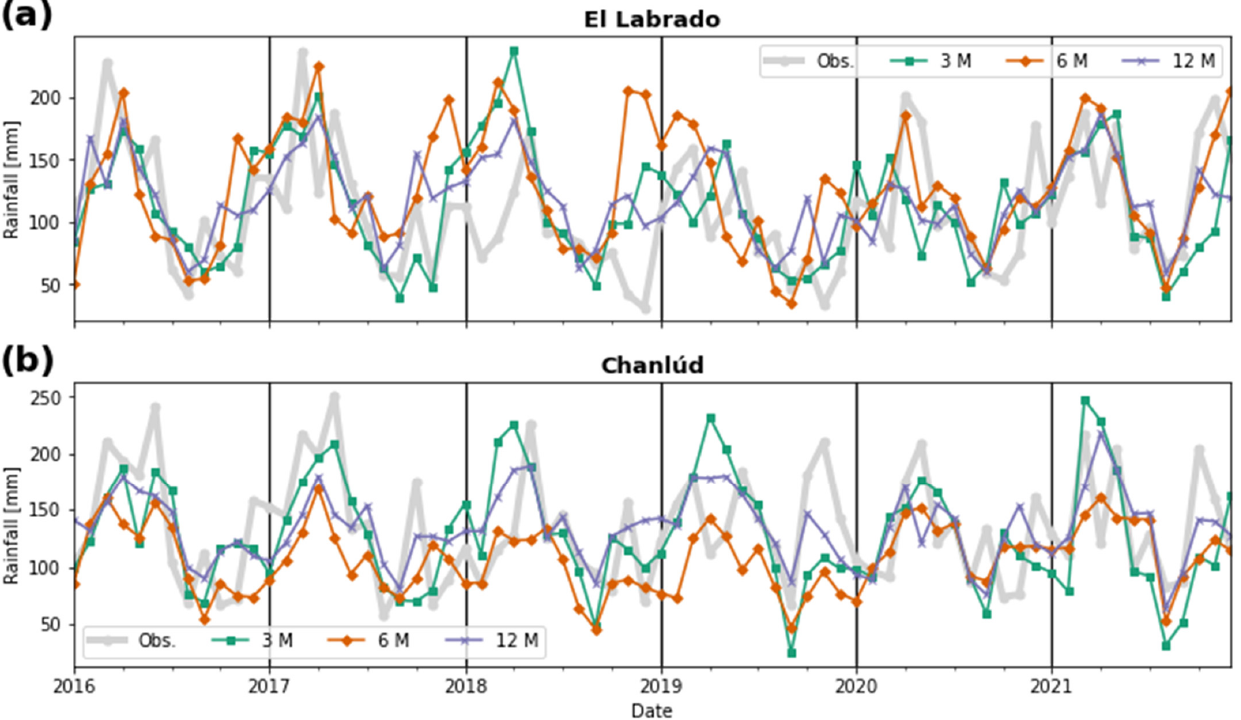
Figure 9. Qualitative evaluation of the models’ performance: ( a ) for El Labrado; ( b ) for Chanlúd. The vertical lines indicate that the forecasts were made for each year individually. vertical lines indicate that the forecasts were made for each year